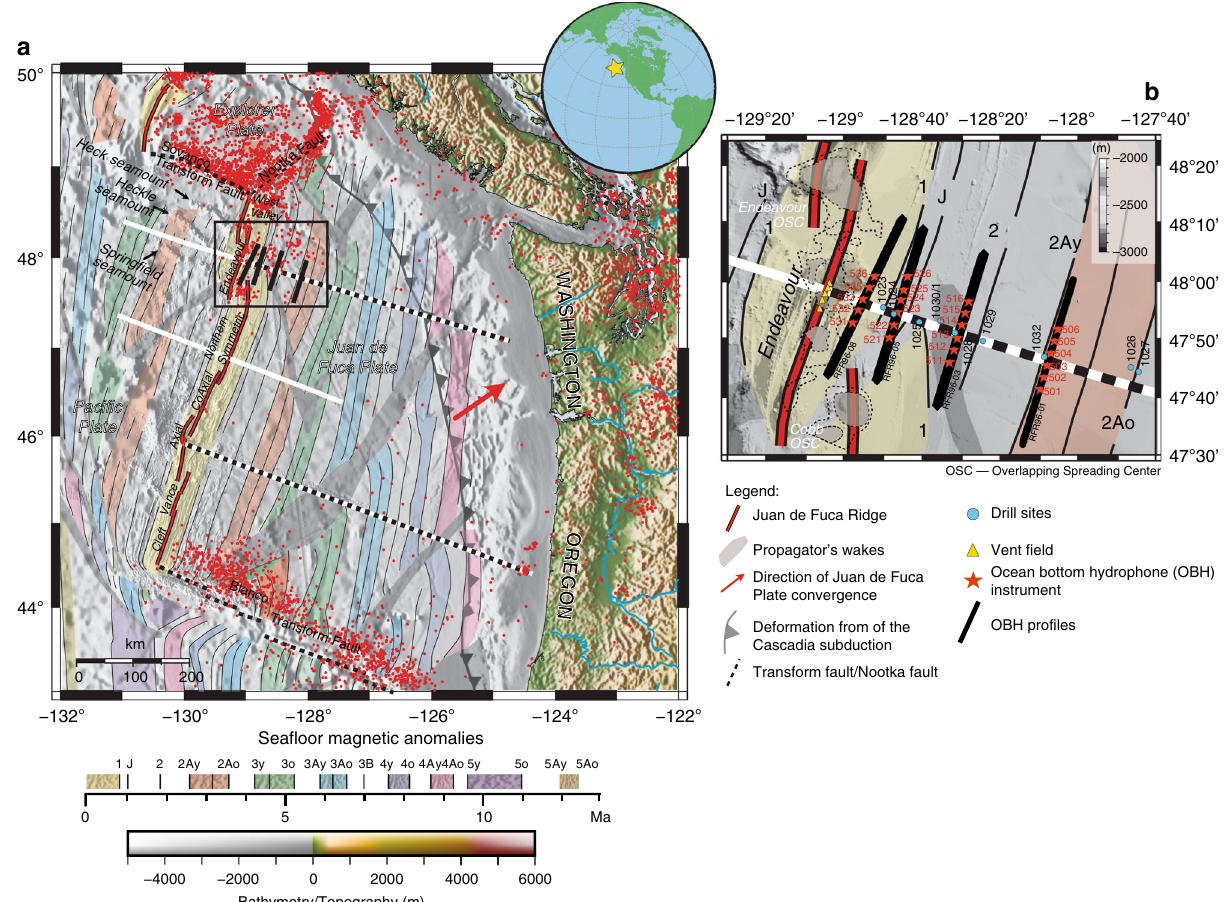
Fig. 1 Study area and the young Juan de Fuca (JdF) Plate. a Regional map of the JdF Plate and Cascadia subduction zone. The inset globe shows the global location of the area marked with the yellow star. Our study area is outlined by a black box (close-up is shown in panel b ). The locations of the seismic re fl ection pro fi les collected in 2002 (refs. 21,53 ) crossing the Endeavour and Northern Symmetric segments are shown in white lines; the locations of the re fl ection seismic pro fi les collected in 2012 41 are shown in white-black lines. Coloured areas bounded by black lines represent the magnetic anomalies with the corresponding age shown in the time scale below the panel 53 . Grey shaded zones outline the extent of the propagator wakes 53 . The red dots represent epicentres along plate boundaries (June 1995 – June 2019, United States Advanced National Seismic System and Canadian National Seismic Network catalogues). b The close-up of the study area. Around the ridge axis, dashed and grey transparent contours outline zones with lower ( ∼ 0%) and higher (3%) melt fraction at 7.8-km depth 28 . The remaining symbols are shown in